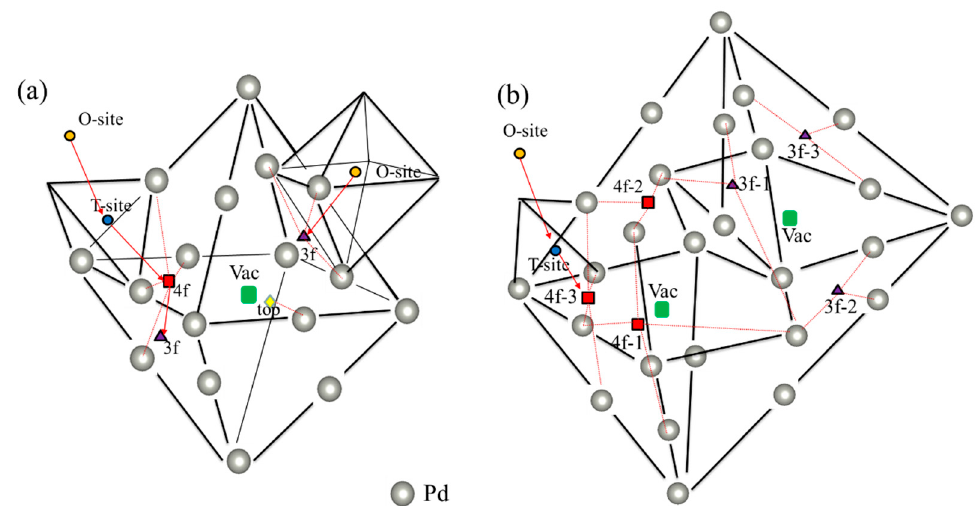
Figure 1. Visualization of relevant interstitial sites at the ( a ) monovacancy and ( b ) divacancy, such as 1vac_top (yellow diamond), 1vac_3f (purple triangle), 1vac_4f (red square), 2Vac_3f − x ( x = 1 − 3) (purple triangle), 2vac_4f − x ( x = 1–3) (red square), as well as the vacancy-nearing O-site (NOS) (orange circle)